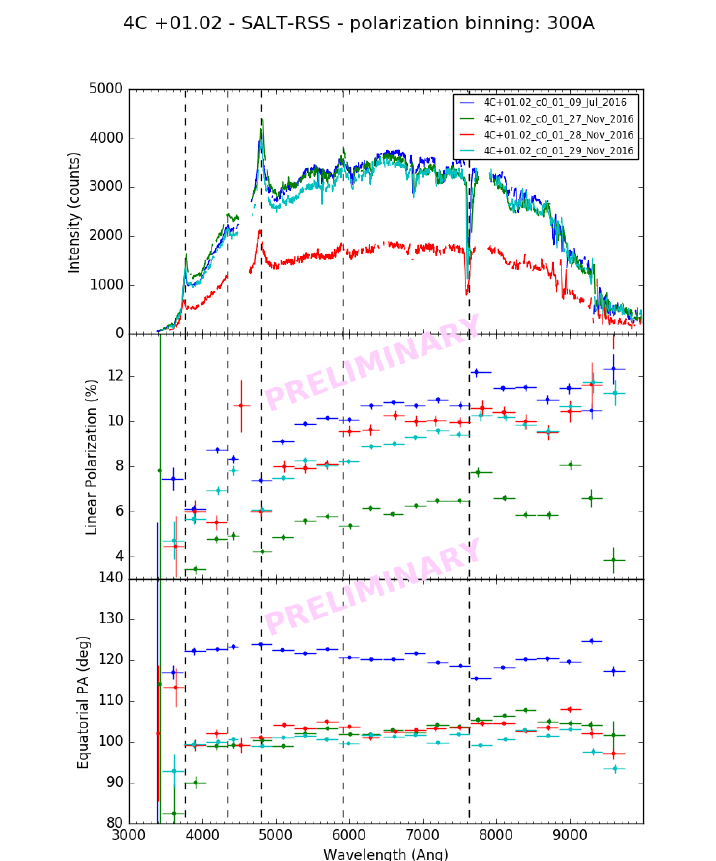
Figure 2. Top panel: Southern African Large Telescope (SALT) Robert Stobie Spectrograph (RSS) count spectra of 4C+01.02 during four observing windows, including the 9 July 2016 flare indicated in Figure 1 (blue). Dashed vertical lines indicate the positions of the following lines: Ly α 1216 Å, Si IV 1400 Å, C IV 1549 Å, C III 1909 Å , and a telluric absorption line. Middle panel: Linear polarization degree as function of wavelength from SALT spectropolarimetry for the four SALT observing windows, as in the top panel. Bottom panel: Polarization angle as a function of wavelength for the four SALT